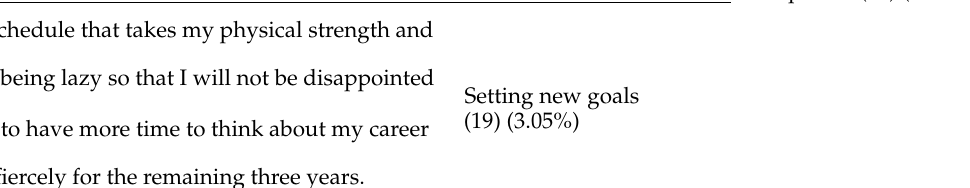
Secondary Topic (General